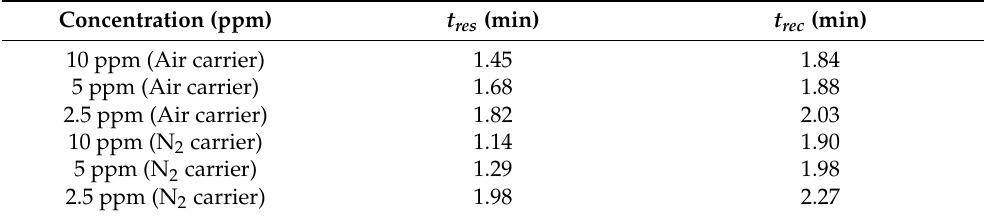
Table 1. Response time, t res , and recovery time, t rec , of In 2 O 3 − x sensor to three different NO 2 concentrations evaluated at the optimal working temperature of 200 ◦ C.